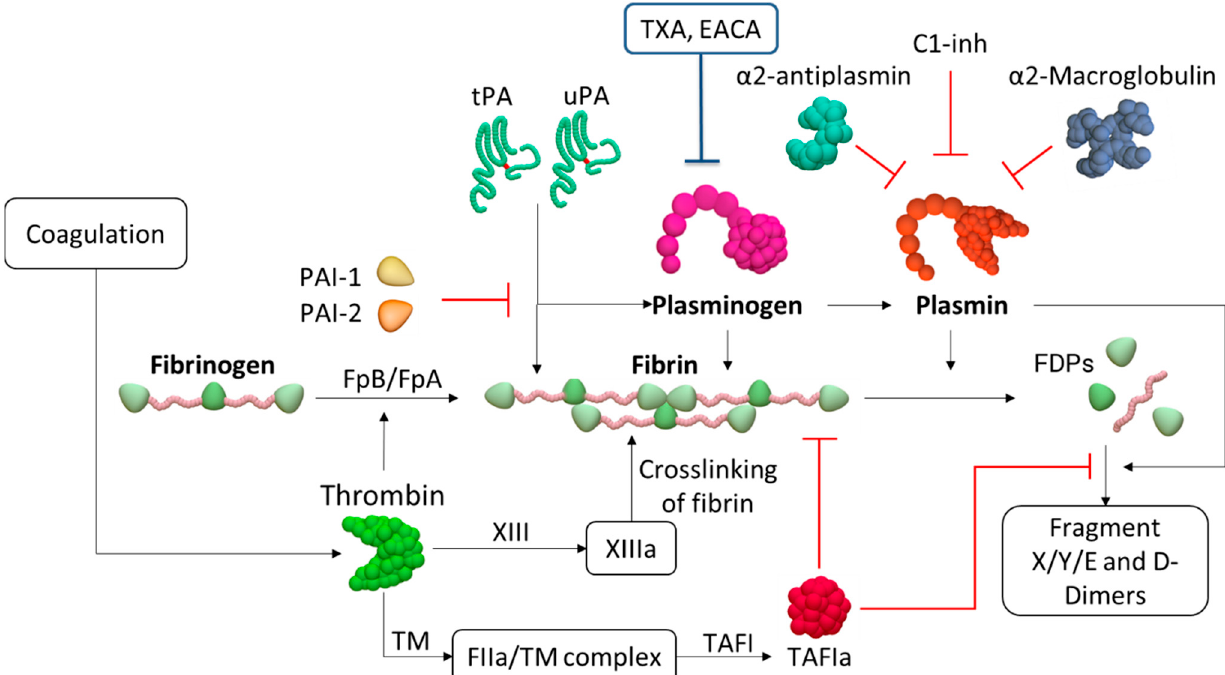
Figure 2. A schematic representation of the fibrinolytic system. Fibrinolysis is initiated when the product of coagulation, thrombin, cleaves fibrinopeptides A and B from fibrinogen, leading to fibrin network formation. Thrombin activates factor XIII that crosslinks fibrin. Tissue plasminogen activator (tPA) or urokinase-type plasminogen activator (uPA) converts plasminogen into plasmin. Plasmin cleaves fibrin into fibrin degradation products (FDPs), including D-dimer. Direct plasmin inhibitors are α 2 -antiplasmin, α 2 -macroglobulin, and C-1 esterase inhibitor (C1-INH). Plasmin formation is also downregulated by several inhibitors, including plasminogen activator inhibitor 1 (PAI-1) which inhibits tPA and uPA. Interaction of thrombin with thrombomodulin (TM) activates thrombin-activated fibrinolysis inhibitor (TAFI). Activated TAFI (TAFIa) reduces plasminogen activation by cleaving C-lysines from fibrin and FDPs. Activation of plasmin can also be inhibited by lysine analogues tranexamic acid (TXA) and ε -aminocaproic acid (EACA).